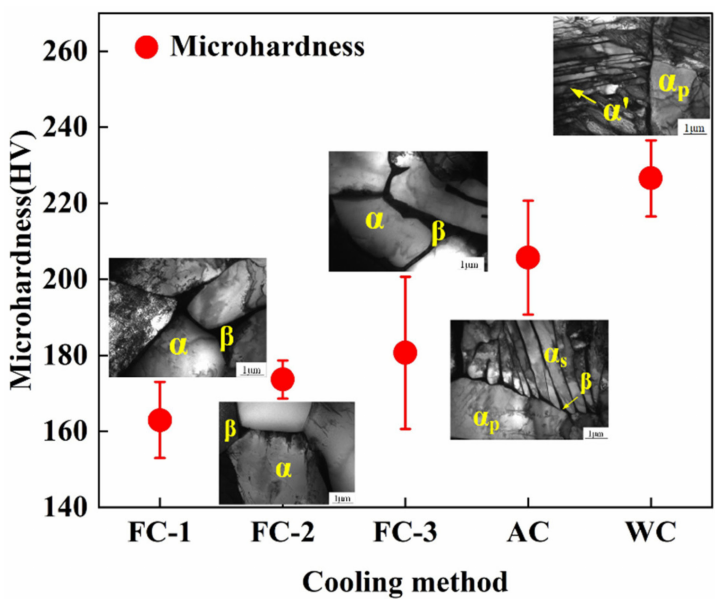
Figure 13. The Vickers microhardness of Zr-4Hf-3Nb (wt%) alloy. with various cooling